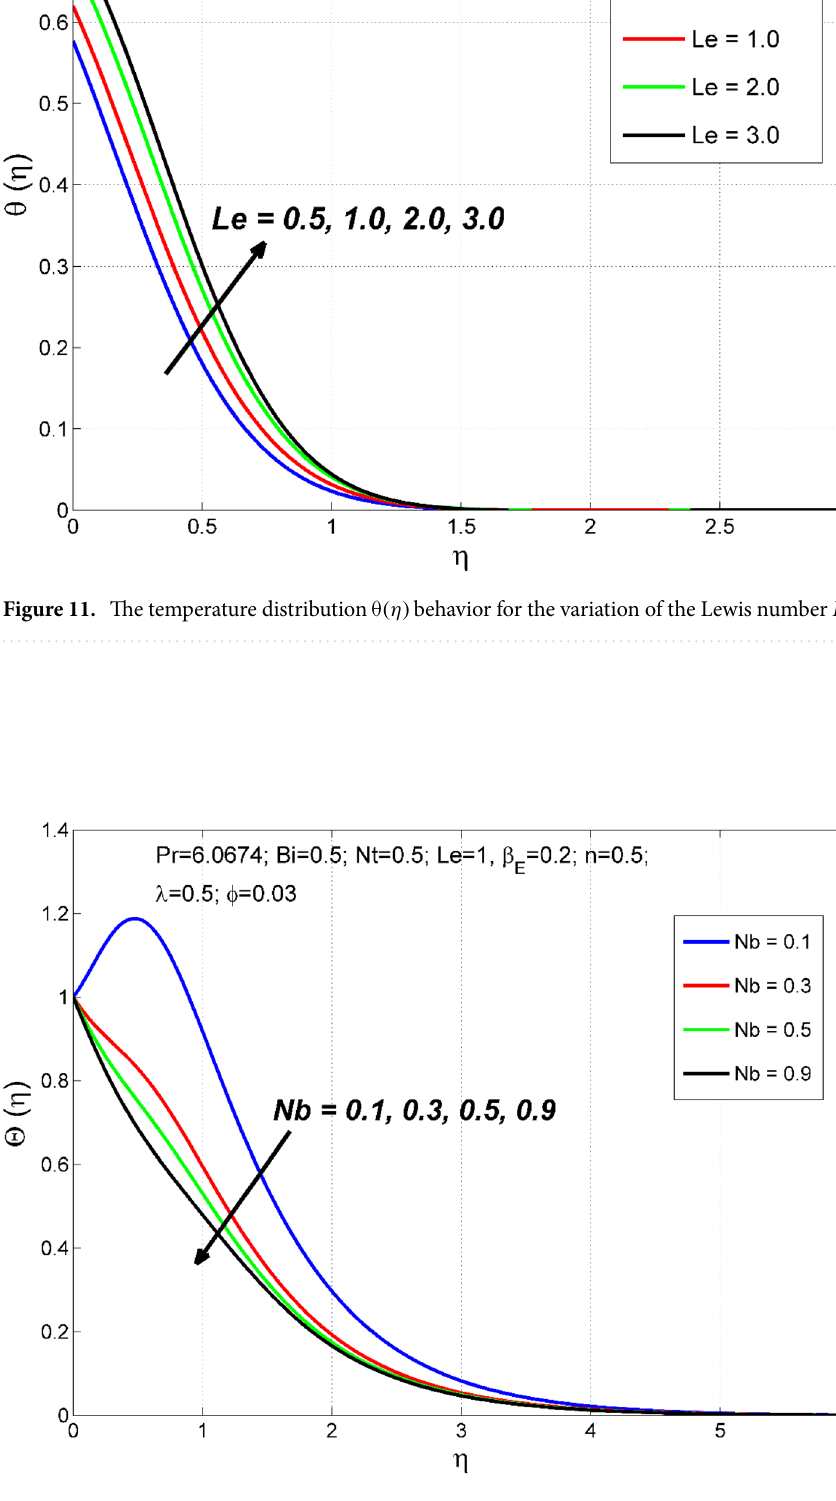
Figure 12. The nanoparticles volume fraction distribution �(η) behavior for the variation of the Brownian motion Nb